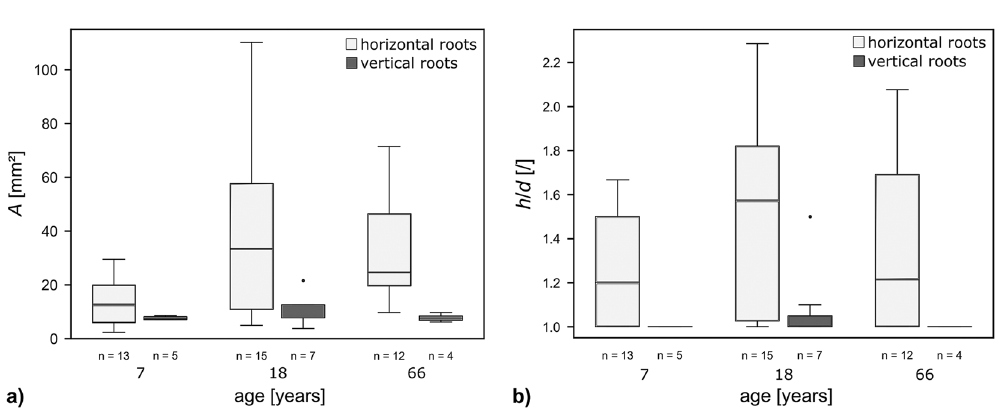
Figure 8. Geometry of horizontally and vertically trained roots developed approximately 7, 18 and 66 years after their implementation in the bridge #50 (see Tables S1 and S2 in Supplementary Information). ( a ) Ratio of height to width ( h / d ), ( b ) mean cross sectional area ( A ). n = sample